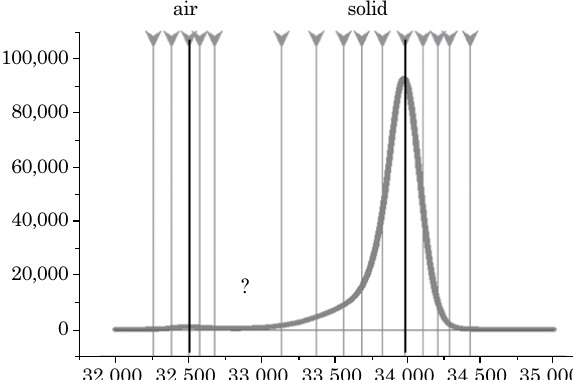
figure 3. histogram representing the different distribution of gray shades in the sample. the black arrows (main arrows) represent the gray values that certainly correspond to air and solid. each of the arrows (main and secondary) provides a maximum center value (mc) and variance (Var). the transition phase corresponds to the distribution of gray values in which there is doubt of what is solid and what is air within the